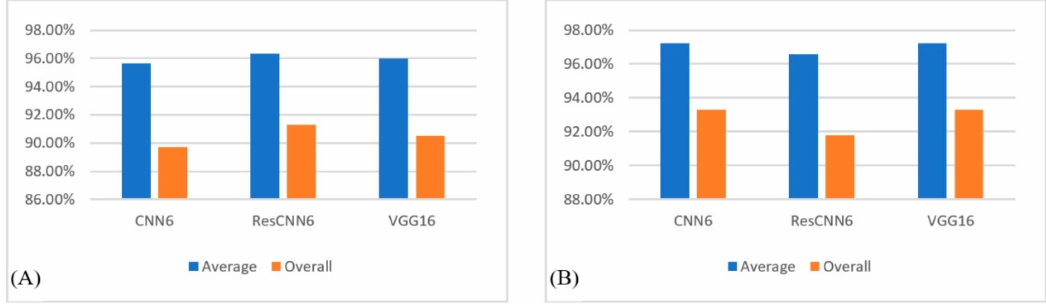
Figure 8. Comparison of average and overall accuracies for running the deep networks on five-class samples: ( A ) by omitting uterine corpus endometrial carcinoma samples and ( B ) by omitting